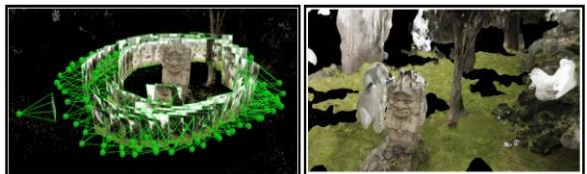
Figure 8. Position of the photographs (left), result of the generation of the 3D model (right).